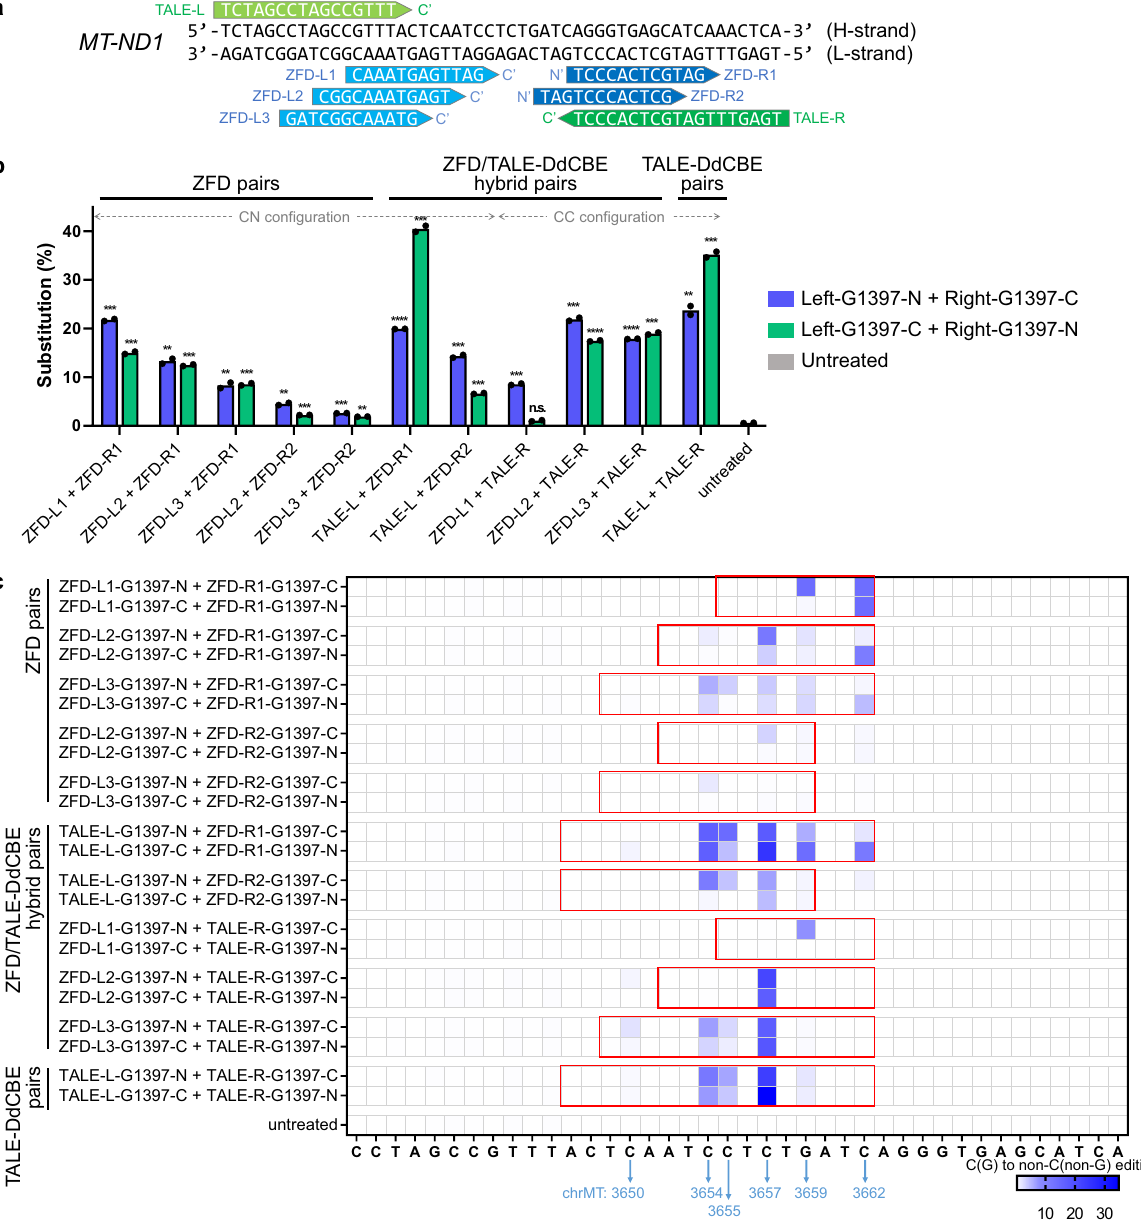
Fig. 4 Activity of mitoZFDs, TALE-based DdCBEs, and ZFD/DdCBE hybrid pairs. a DNA sequences of the binding regions of the mitoZFD and TALE- DdCBE pairs. Sites recognized by the TALE-DdCBEs are highlighted in green and for the mitoZFDs in blue. The upper sequence represents the mtDNA heavy strand and the lower sequence represents the mtDNA light strand. b Frequencies of cytosines edited by ZFDs, TALE-DdCBEs, and ZFD/DdCBE hybrid pairs. All statistical analysis for comparing with untreated samples was conducted using unpaired Student ’ s t -test (two-tailed) in GraphPad Prism 8. Statistical signi fi cance as compared with untreated samples was denoted with * P ≤ 0.05, ** P ≤ 0.01, *** P ≤ 0.001, **** P ≤ 0.0001, n.s. (not signi fi cant) P > 0.05. Data are shown as means from n = 2 biologically independent samples. c Heat maps of base editing activities at each base position. The red box indicates the spacer region for each construct. The blue arrows indicate the position in the mtDNA. Source data are provided as a Source Data fi